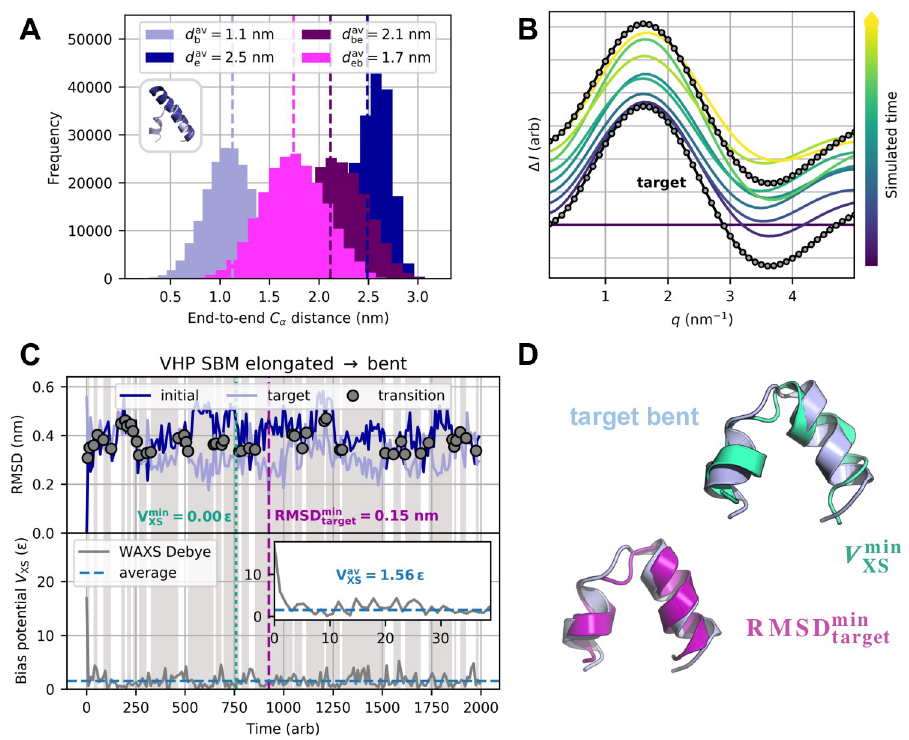
Fig 1. Proof-of-concept simulations for VHP-based polypeptide system. Results are shown for parameters ( T , k χ ) = (90, 5 � 10 − 8 ε ). (A) End-to-end C α distance distributions. Inset: Bent (light blue) and elongated (dark blue) conformation have inter-terminal distances of 1.07 nm and 2.68 nm, respectively. d av end-to-end distances for free bent (light blue), free elongated (dark blue), scattering-guided elongated-to-bent (magenta), and scattering-guided bent-to-elongated (purple) SBM simulations. (B) Artificial difference scattering data for elongated-to-bent transition. 50 equidistant q points between 0.1 nm − 1 and 5 nm − 1 were included (grey circles). Debye intensities of structures from equidistant time points in the simulation (blue to yellow) are displayed with small offsets. (C) Initial and target RMSD (top) and bias energy (bottom) versus simulated time. With both initial (elongated, dark blue) and target (bent, light blue) RMSD proceeding in close proximity, multiple structural transitions (grey circles) occurred back and forth. V XS initially decreased significantly and further exhibited small-scale fluctuations throughout the refinement. (D) Best structures in terms of minimum target RMSD and bias energy. RMSD min (purple) and V min (turquoise) structure have target RMSDs of 0.15 nm and 0.27 nm, XS